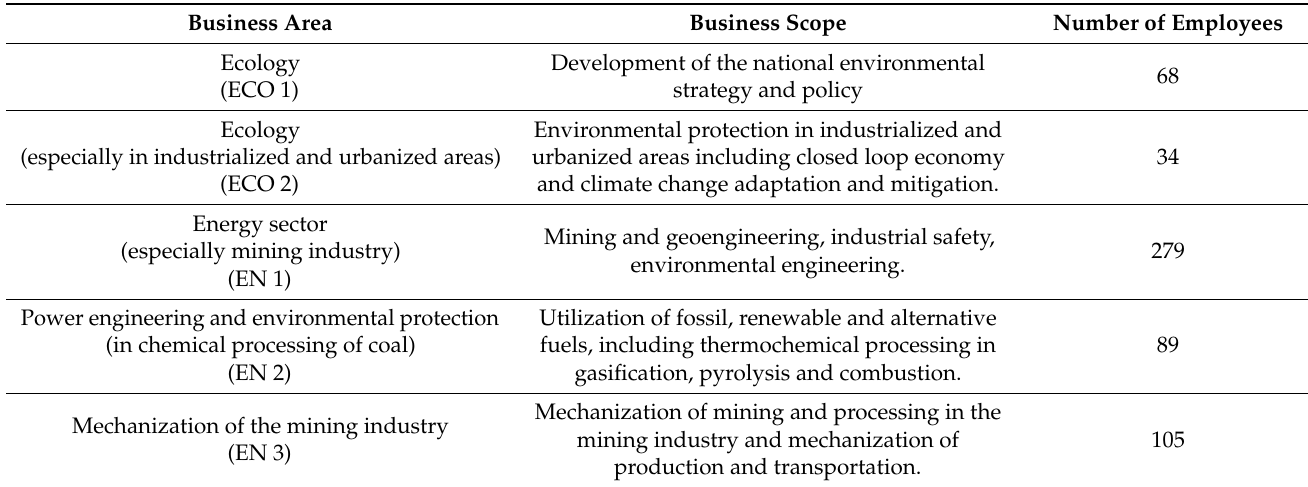
Table 1. The characteristics of the entities selected for the study.